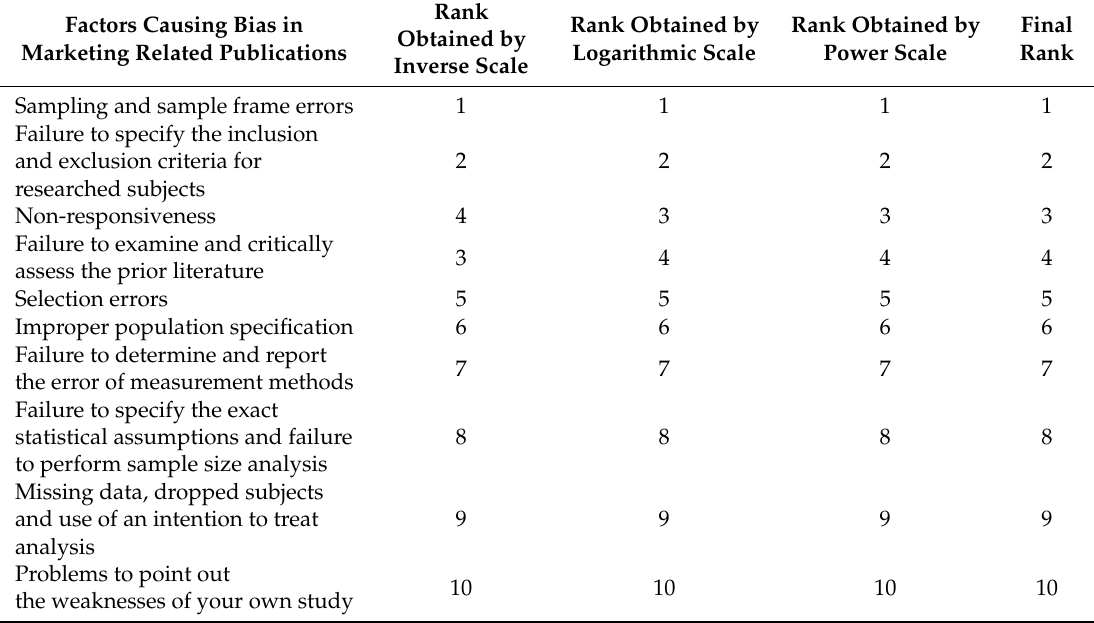
Table 3. Ranks of researched